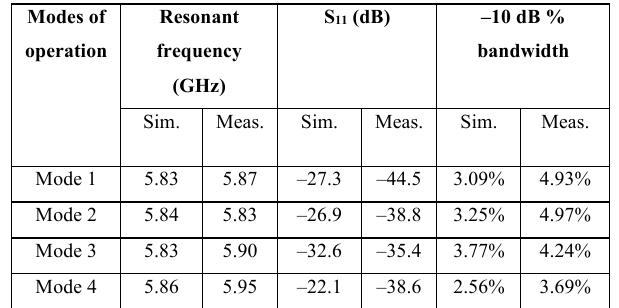
TABLE II. Comparison of simulated and measured resonant frequency, S 11 and –10 dB percentage bandwidth.